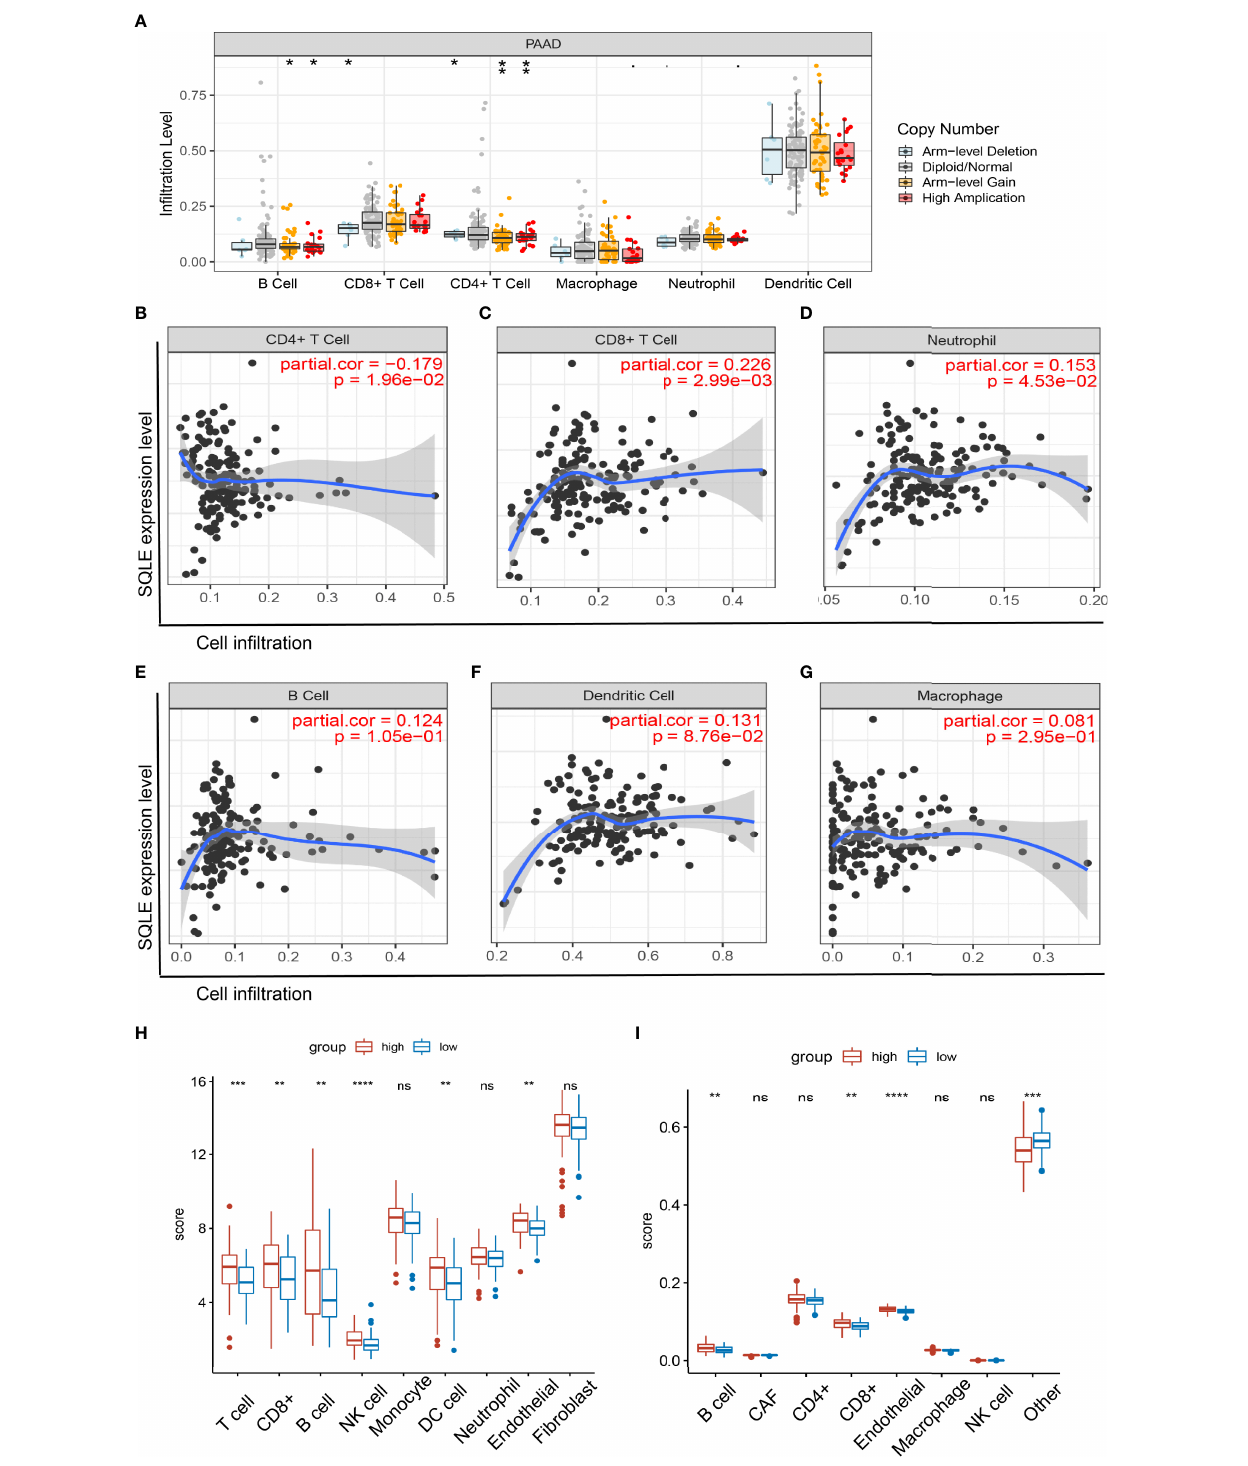
FIGURE 5 | Relationship of immune cell in fi ltration with SQLE expression in PAAD. (A) In fi ltration of immune cells under different alterations of SQLE in PAAD. (B – G) Correlation of SQLE with CD4+ T cells (B) , CD8+ T cells (C) , neutrophils (D) , B cells (E) , dendritic cells (F) , and macrophages (G) . (H, I) Differences of immune-in fi ltrating cells between SQLE high (n = 89) and low (n = 89) groups performed by McP-Counter (H) and EPIC (I) . *p < 0.05, **p < 0.01, ***p < 0.001, and ****p < 0.0001. NS, no signi fi